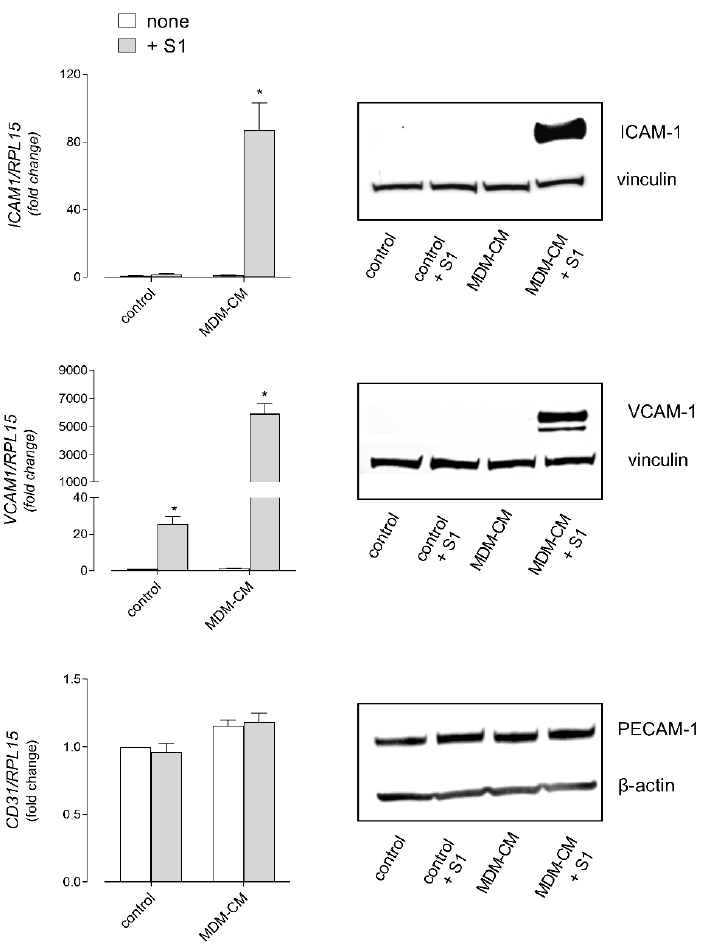
Figure 5. HLMVEC were incubated for 6 h in fresh RPMI1640 growth medium (control) in the absence (none) or in the presence of 10 nM SARS-CoV-2 spike protein supplemented with 2 µg/mL Polymixin B (S1) or in MDM conditioned medium (MDM-CM), obtained by incubating MDM for 16 h in the absence (none) or in the presence of 10 nM S1 and 2 µg/mL Polymyxin B. The expression of the indicated genes ( left panels) was then measured by means of RT-qPCR, normalized for that of the housekeeping gene RPL15, and expressed relative to none in control cells (=1); data are means ± SEM of three experiments, each performed in duplicate. * p < 0.05 vs. none in control with “one-sample t -test”. The amount of the corresponding proteins ( right panels) was assessed by means of Western Blot analysis (see Section 2); the representative blots shown were repeated twice and gave comparable results.